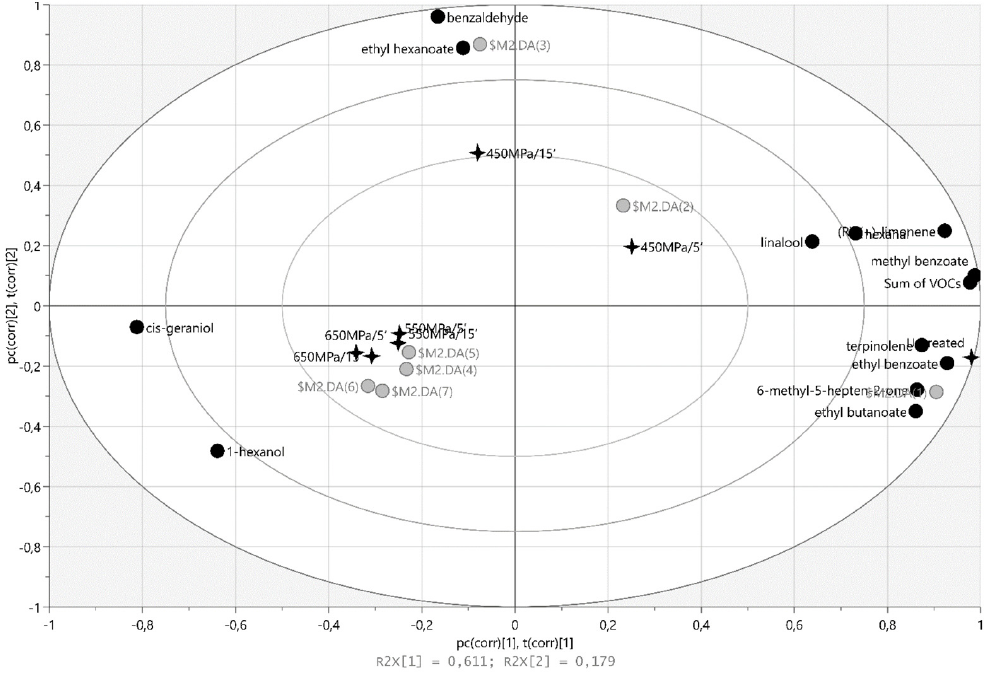
Figure 3. The bi-plot of PLS-DA for VOCs identified in the untreated and HHP-treated (450–550– 650 MPa/5 and 15 min) cv Geneva.